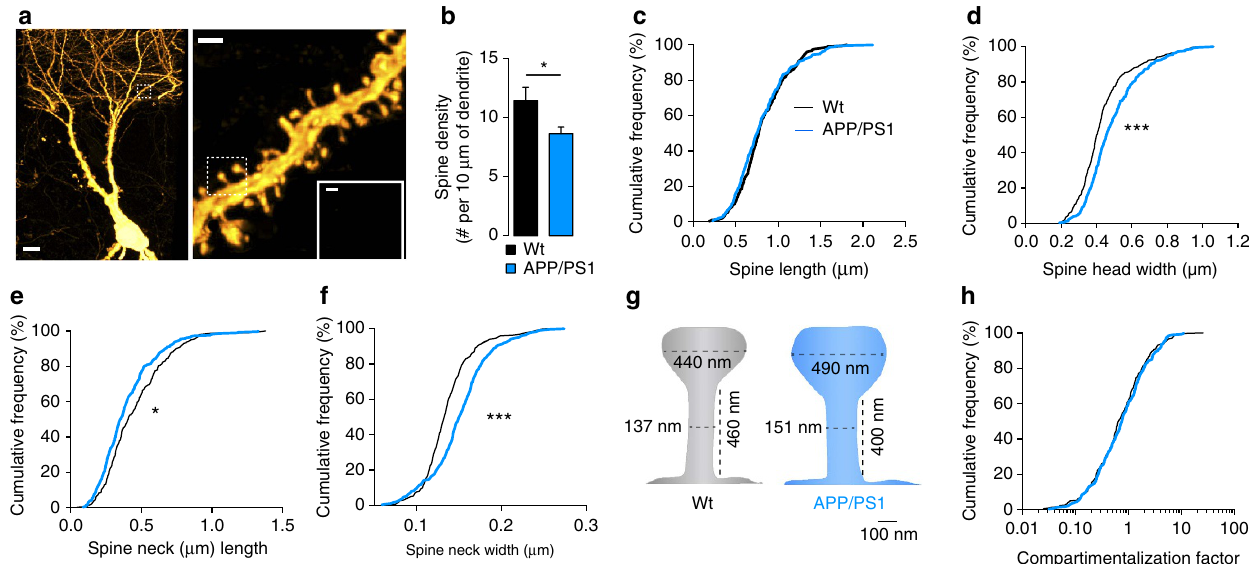
Figure 2 | Alterations in A/C spine morphology. ( a ) Representative STED images obtained from RABV D G-GFP(RG) infected neurons. Scale bar, left panel, 10 m m; right panel, 1 m m; inset, 250nm. ( b ) Bar graph summarizing the reduction of spine density. Several branches of distal dendrites of CA3 PCs were analysed in wt ( n ¼ 8 branches, 4 mice) and in APP/PS1 mice ( n ¼ 9 branches, 4 mice; * P ¼ 0.037, unpaired t -test). ( c ) Cumulative distribution illustrating the absence of any difference in spine lengths between both genotypes (Kolmogorov–Smirnov (KS) test P ¼ 0.144). Number of spines analysed was equal for graphs from c to h , n ¼ 300 for wt and n ¼ 288 for APP/PS1, from four mice for each genotype. ( d ) Cumulative distribution of spine head width (KS-test *** P o 0.0001), ( e ) spine neck length (KS-test * P ¼ 0.015) and ( f ) spine neck width (KS-test *** P o 0.0001) from wt and APP/PS1 mice. ( g ) Schematic spines illustration of morphological alterations observed in A/C spines with mean values indicated. ( h ) The cumulative distribution of the compartmentalization factor calculated for each spine was not different between wt (1.35 ± 0.13) and APP/PS1 mice (1.35 ± 0.10, P ¼ 0.063, KS-test). NATURE COMMUNICATIONS|7:11915|DOI: